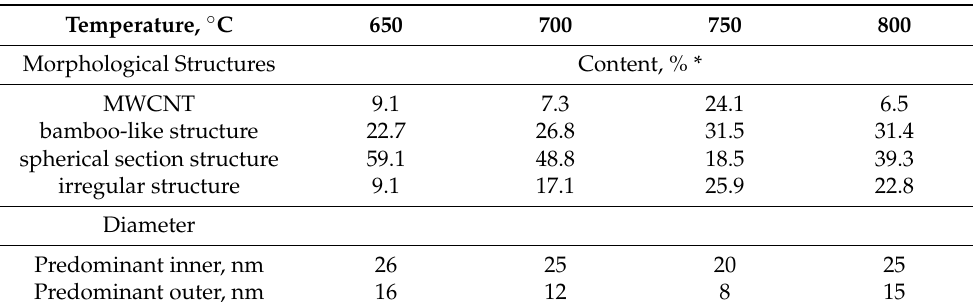
Table 6. Percentage of different morphological structures in the samples obtained at different tem- perature (NH 3 content in reagent mixture—50% vol.).